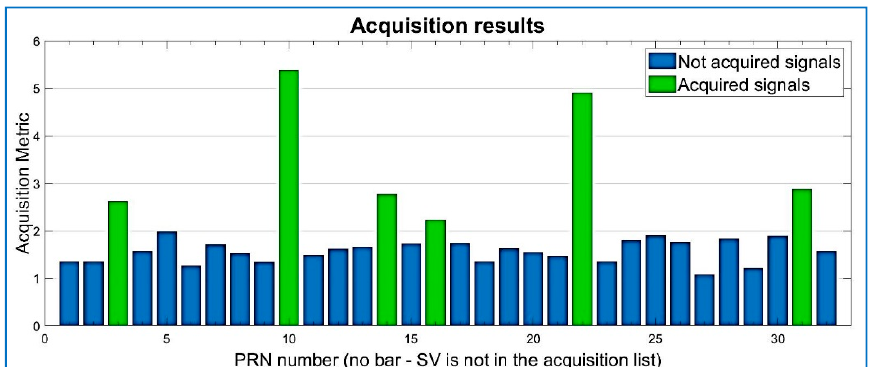
Figure 10. Acquired PRNs from Dataset 2. R = 0.03.